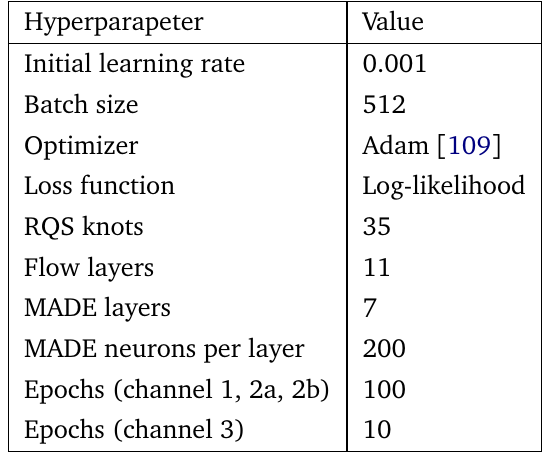
Table 15: Parameter combinations used for training the spline autoregressive flow